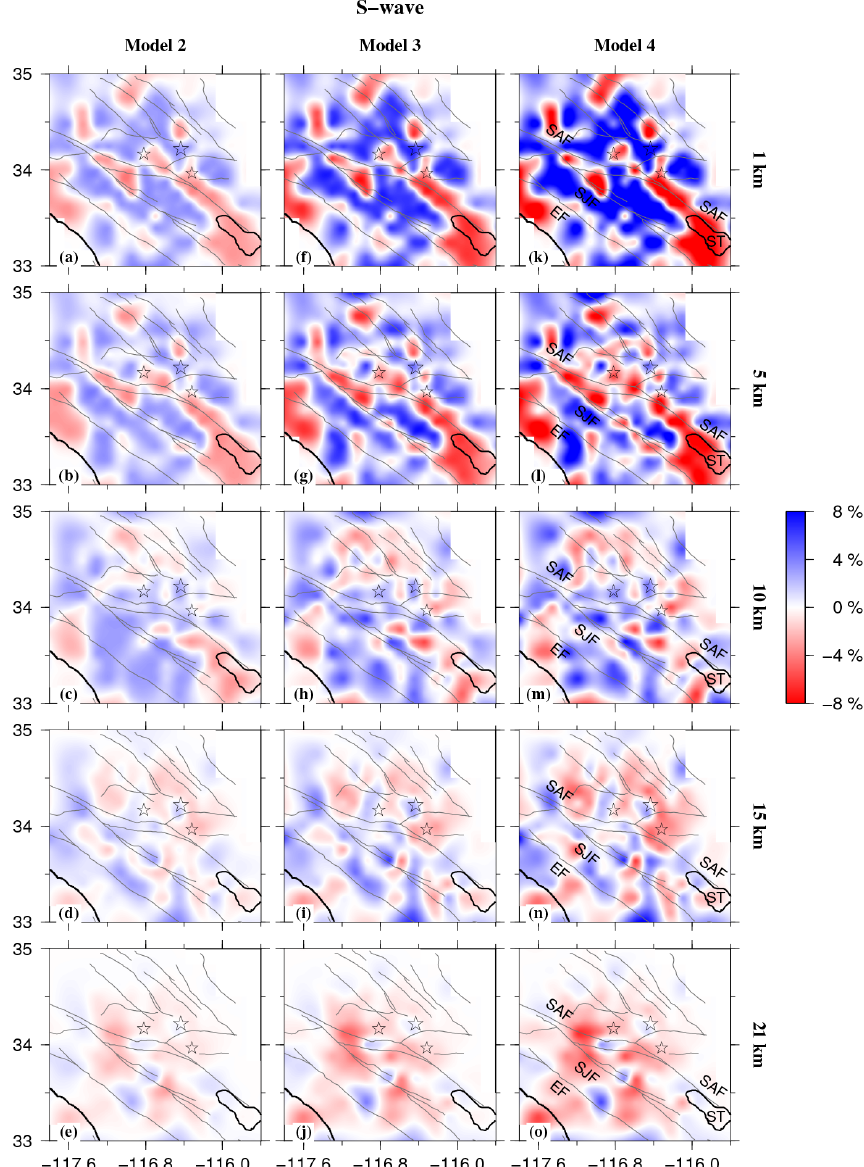
Figure 13. The same as Fig. 12 but for S wave